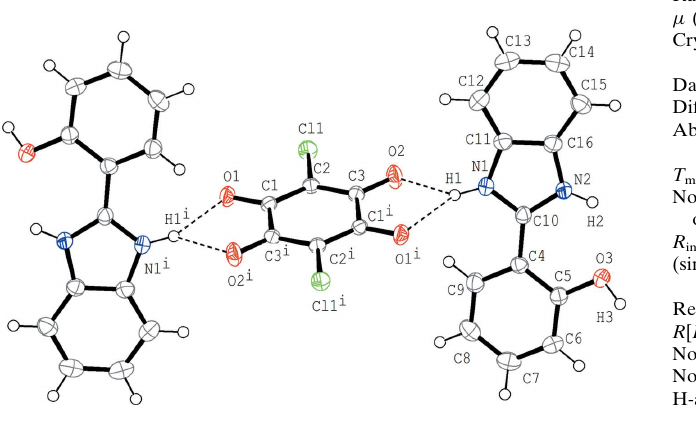
Figure 1 Molecular structure of the title compound, showing the atom-numbering scheme. Displacement ellipsoids are drawn at the 50% probability level and H atoms are shown as small spheres of arbitrary radii. Dashed lines indicate the bifurcated N—H (cid:2)(cid:2)(cid:2) (O,O) hydrogen bonds.